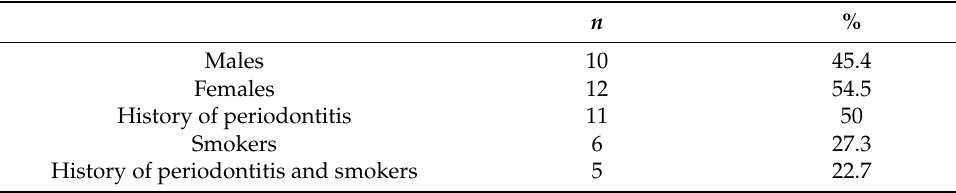
Table 1. Description of the main features of the studied population. n % Males 10 45.4 Females 54.5 History of periodontitis Smokers 27.3 History of periodontitis and smokers 5 22.7